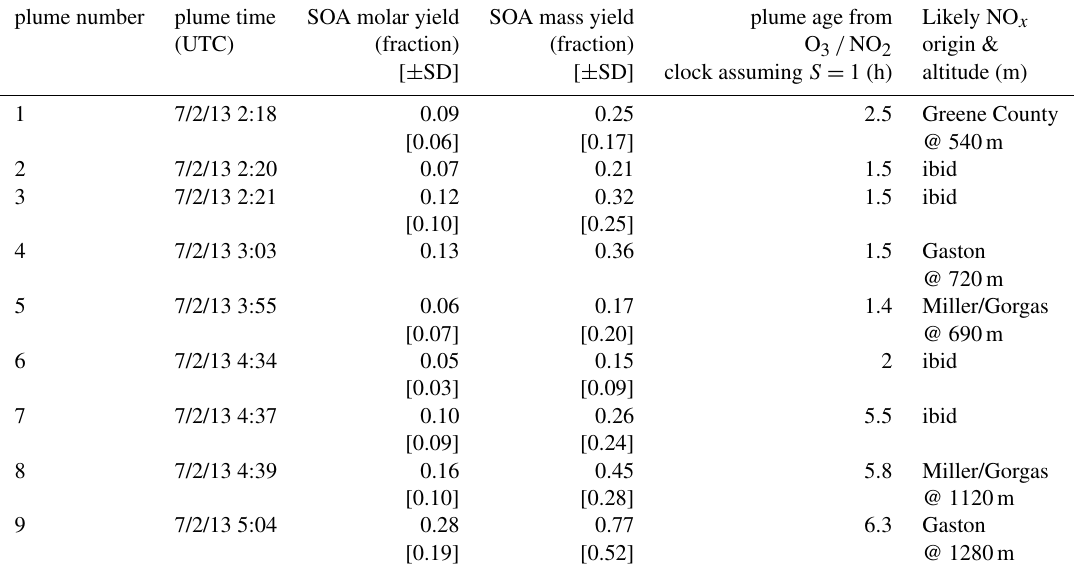
Table 2. SOA Yields for each plume observation, estimated plume age, and likely origin. See text for description of uncertainty estimates. For the mass yields, the calculated SOA mass increase includes both the organic and (organo)nitrate aerosol mass; the measurements for OA increases shown in Fig. 6 do not include the nitrate